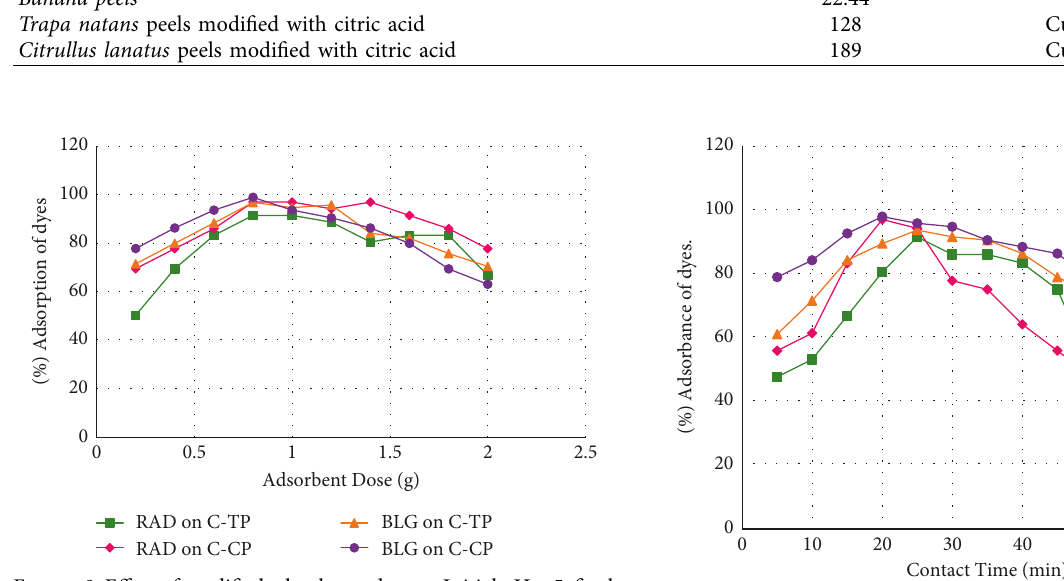
Figure 9: Effect of modified adsorbents dosage. Initial pH � 5, final pH for RAD on C-TP and C-CP � 4, BLG on C-TP � 4.5, and BLG on C-CP � 4.